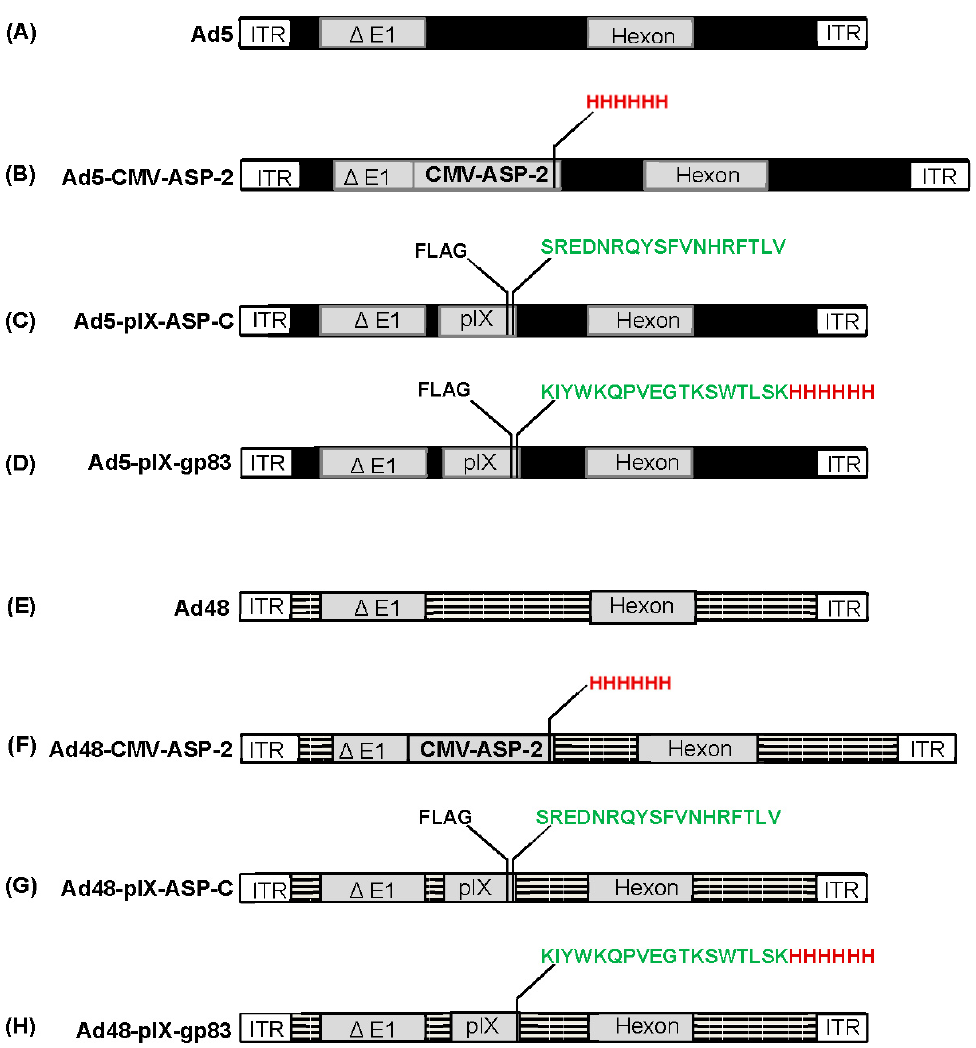
Figure 1. Schematic representation of the Ad5 and Ad48 modified vectors involved in this study. ( A ) Ad5, a replication-defective adenovirus with wildtype Ad5-CMV-ASP-2,